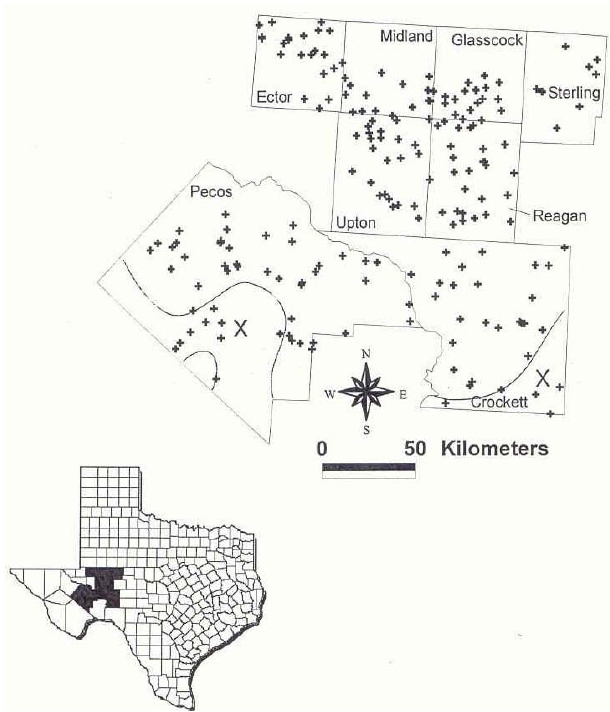
FIGURE 1. Study area and sampled water wells. X designates area sparsely occupied by oil